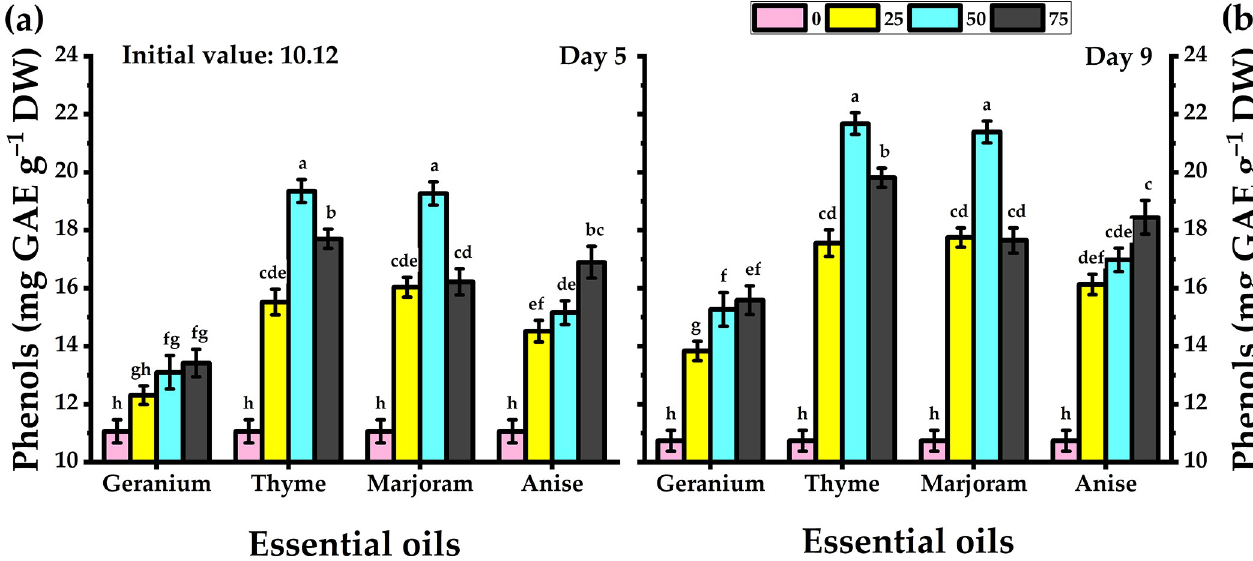
Fig 5. Response of carnation cut flowers to geranium, thyme, marjoram, and anise essential oils at 0, 25, 50, and 75 mg/L concentrations as preservative solutions on phenols content at day 5 and day 9 of vase life period. Bars with the same letters are not significantly differed at p � 0.05 level.